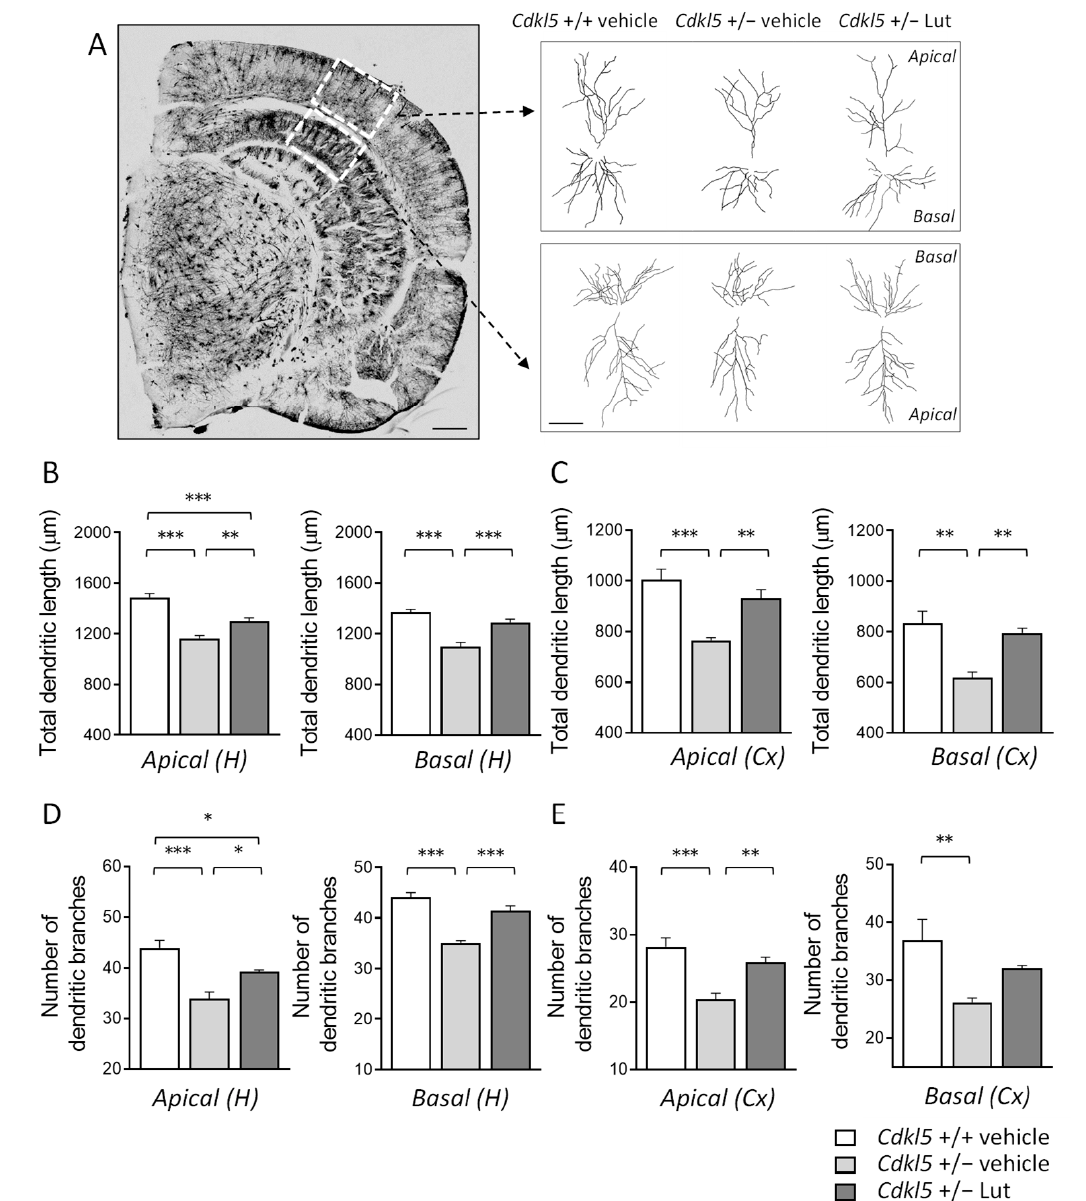
Figure 4. Effect of luteolin treatment on dendritic architecture of hippocampal and cortical neurons of Cdkl 5 +/ − mice. ( A ) Representative image of a Golgi-stained section (panel on the left; scale bar = 500 µ m), showing the portion of hippocampal and cortical regions where the dendritic arbor of pyramidal neurons was traced (areas enclosed in the dashed square). On the right, examples of the reconstructed apical and basal dendritic tree of Golgi-stained cortical (upper) and CA1 (lower) pyramidal neurons of one animal from each experimental group. Scale bar = 40 µ m. ( B , C ) Total dendritic length of apical (on the left) and basal (on the right) dendrites of Golgi-stained pyramidal neurons in the CA1 field ( B ) and cortex ( C ) of vehicle-treated Cdkl 5 +/+ (n = 4) and Cdkl 5 +/ − (n = 4) mice and luteolin-treated Cdkl 5 +/ − (n = 4) mice. ( D , E ) Number of dendritic branches of apical (on the left) and basal (on the right) dendrites of Golgi-stained pyramidal neurons in the CA1 field ( D ) and cortex ( E ) of mice as in ( B ). H = hippocampus; CX = cortex. Values are represented as means ± SEM. * p < 0.05, ** p < 0.01, *** p < 0.001. Fisher’s LSD test after one-way